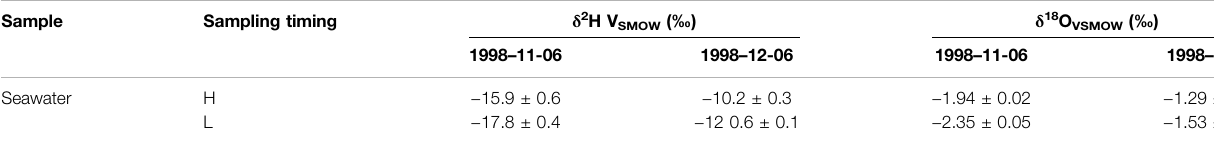
TABLE 3 | δ 2 H and δ 18 O of coastal seawater in Xiamen.